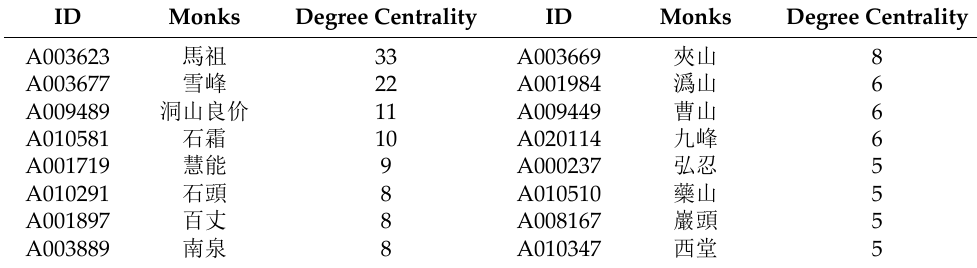
Table 1. Figures ranked by degree centrality ( ≥ 5) in the ZTJ ’s genealogical